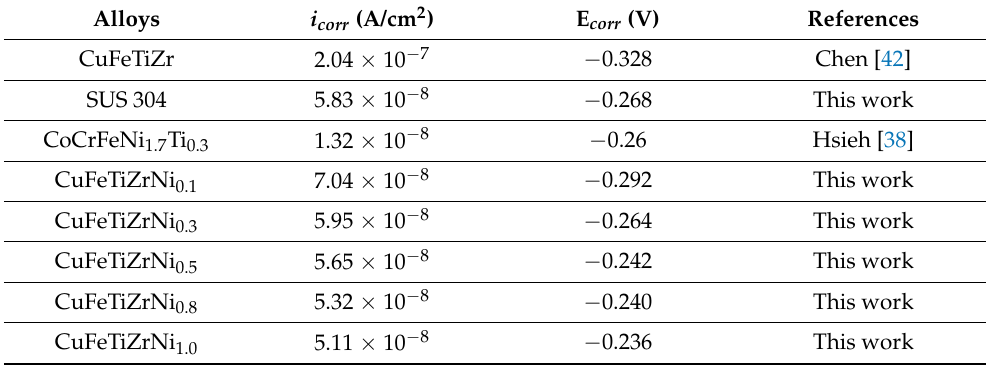
Figure 8. The polarization curves for the CuFeTiZrNi x alloys, CuFeTiZr [36], and SUS304 in 3.5 wt.% NaCl solution. Table 4. The electrochemical parameters of the CuFeTiZrNi x alloys, CuFeTiZr, and SUS 304 in 3.5 wt.% NaCl solution.